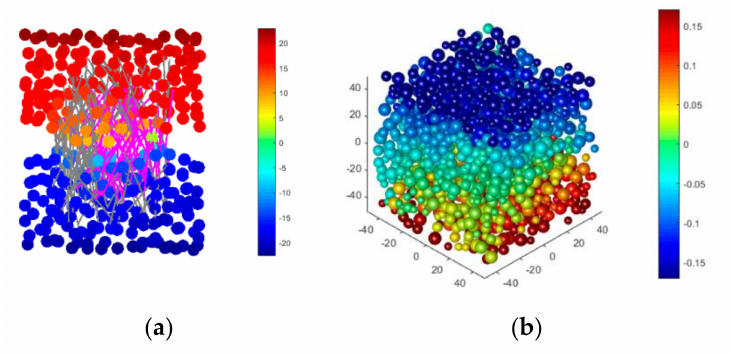
Figure 2. Virtual testing of SFRC specimens: ( a ) double-edge-notched (DEN) uniaxial tension test; ( b ) uniaxial compression test. From